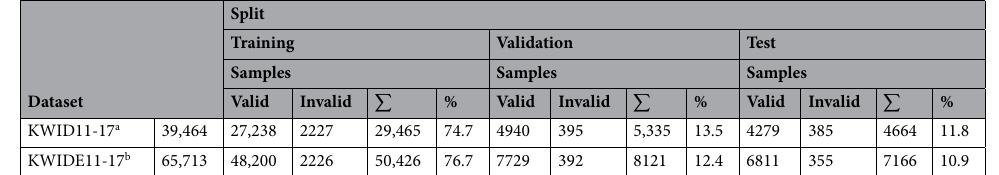
Table 3. Killer Whale Individual Dataset 2011–2017 (KWID11-17), including machine-annotated data of valid images (dorsal fin + saddle-patch) for the 100 most commonly photographed individuals satisfying the data constraints (one label per image + exactly one bounding box prediction), in combination with machine- annotated invalid data utilizing VVI-DETECT after applying the interval rule of 5 s. Killer Whale Individual Dataset Extended 2011–2017 (KWIDE11-17) extends the KWID11-17 data archive with images of the 100 most common individuals represented in images containing more than one label and classified via the first version of FIN-IDENTIFY, trained on KWID11-17. Notice that the distribution of the invalid photos differs slightly between KWID11-17 and KWIDE11-17 due to the different data splits and subsequent effect of the 5 s interval rule. Furthermore, additional statistics regarding the number of identification images (100 classes) are reported for both datasets. a KWID11-17 Killer Whale Individual Dataset 2011–2017—Statistics on the number of identification images (100 most common classes): mean = 364.57, stdv = 162.91, min = 135 (T073B), max = 916 (T019B) training stats (only valid images): mean = 272.38, stdv = 125.79, min = 107 (T073B),